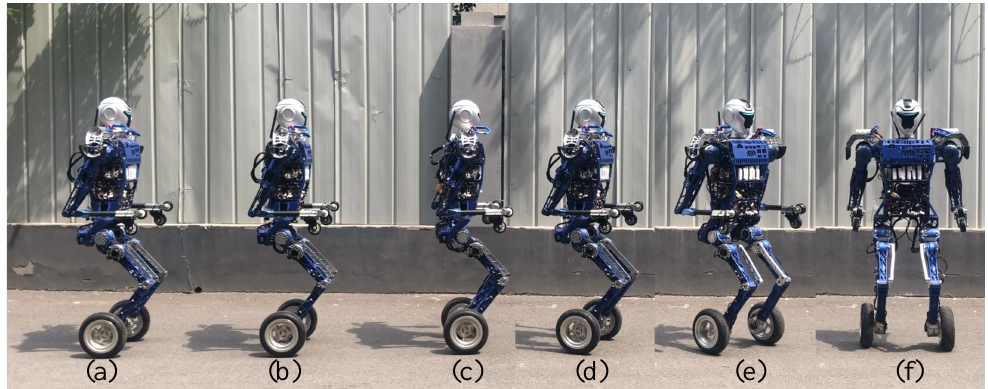
Figure 11. Upright balanced moving experiment on the outdoor road: ( a – c ) Forward experiment; ( d – f ) Turning experiment.